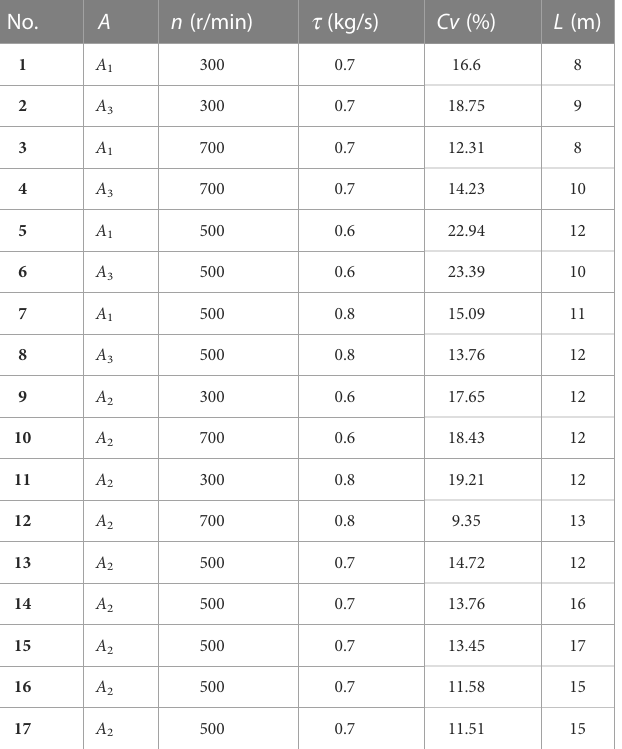
TABLE 7 Bench test scheme and results.